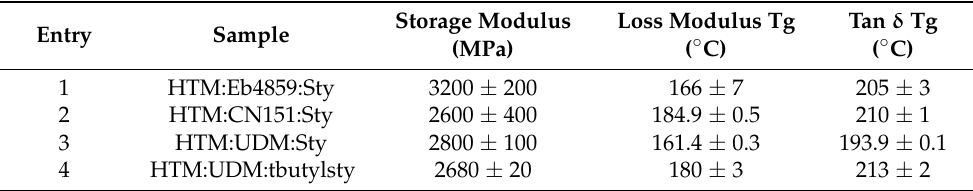
Table 3. DMA data of ternary photocured HTM